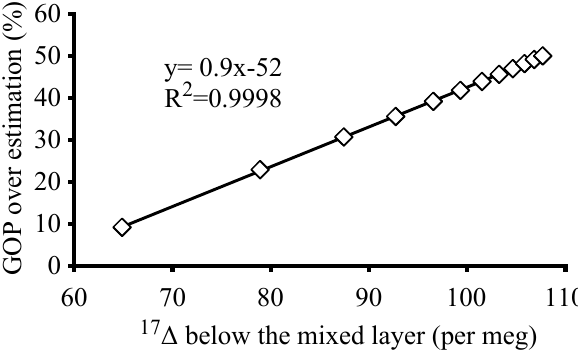
Fig. 2. Linear regression analysis of model simulation re- sults, showing the increase in mixed-layer GOP overestimation ((G 17 OP PRO /GOP M − 1 ) · 100) versus 17 1 below the mixed